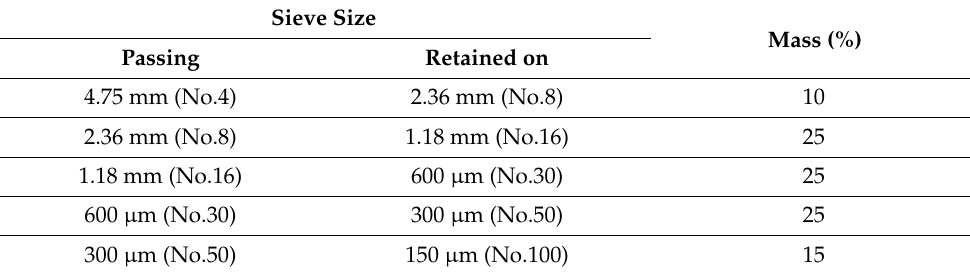
Table 3. Gradation of converter slag used in this work (as specified in ASTM C